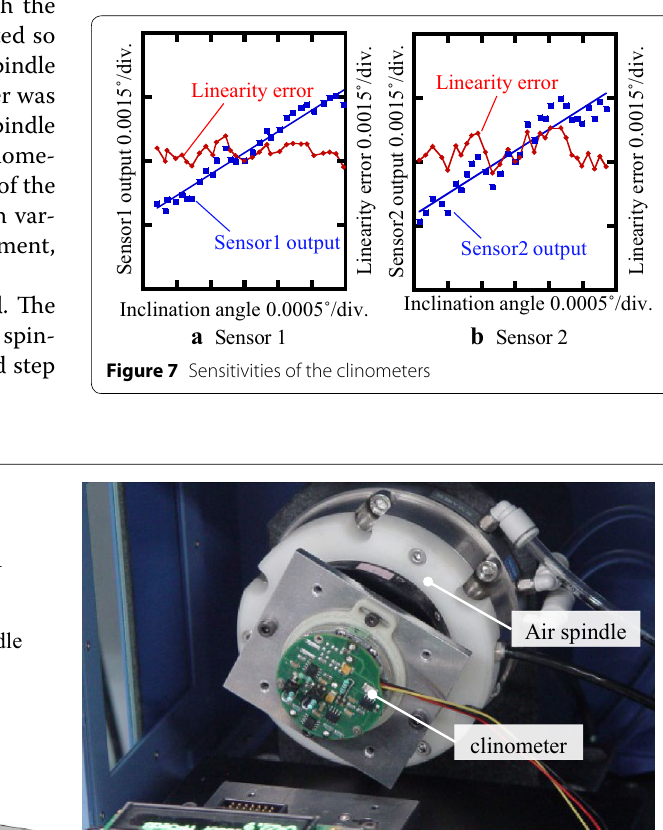
Sensor electronics